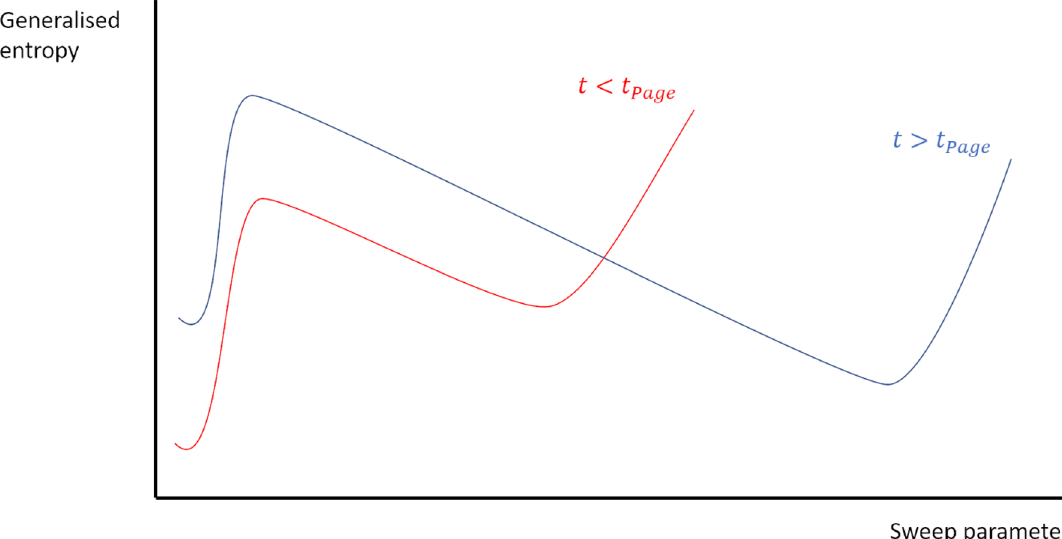
Figure 15 . The size of the cut for the slices of (cid:12)gure 14 as a function of the sweep parameter. For t < t page , the minimum generalized entropy cut is at the beginning, when the bulk entanglement between the black hole and the Hawking radiation is being cut. For t < t page , the minimum generalized entropy cut is near the end, when the cut is near the black hole horizon. In both cases, the largest cut comes near the beginning, when the generalized entropy is the sum of the semiclassical entropy of the radiation, plus the initial Bekenstein-Hawking entropy of the black